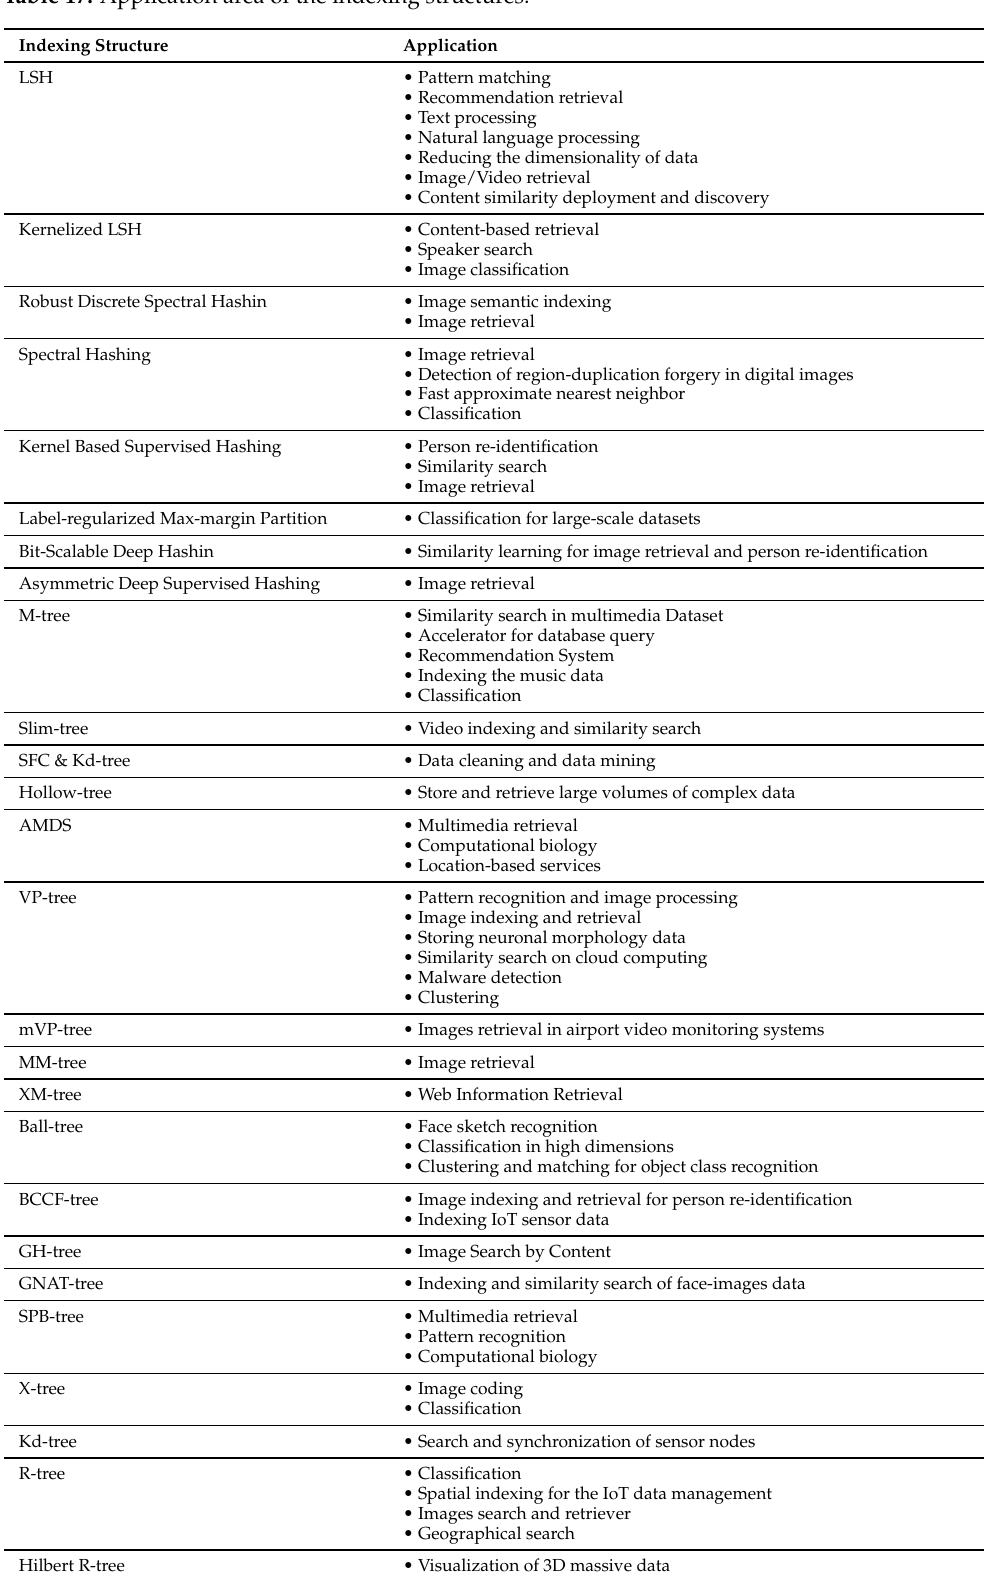
Table 17. Application area of the indexing